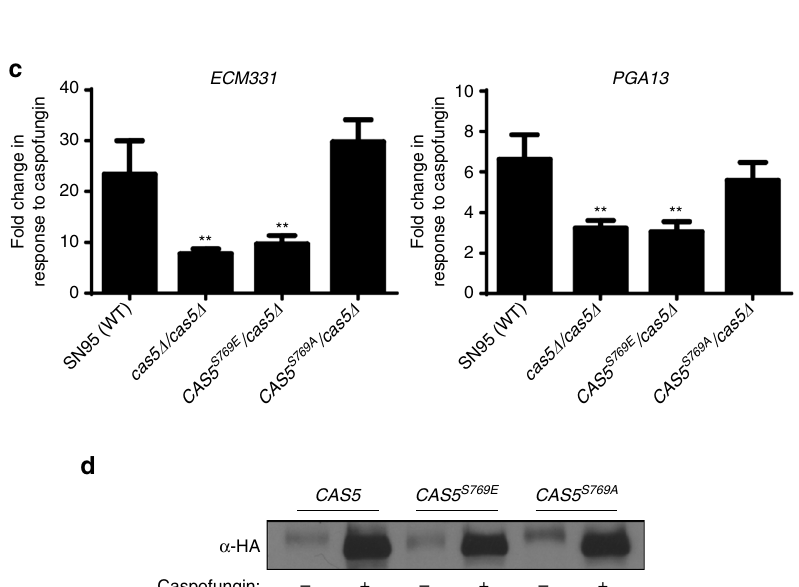
Fig. 6 The S769E substitution in the Cas5 DNA-binding domain phenocopies CAS5 deletion. a Schematic showing the position of S769 in the Cas5 zinc fi nger domain and the alignment of Cas5 orthologs in related fungal species. The alignment was performed using the Candida Genome Database (CGD), and the phosphorylation site-prediction score was generated using NetPhos. b The phosphomimetic S769E substitution in Cas5 confers hypersensitivity to caspofungin. Caspofungin susceptibility assays were conducted in YPD medium. Growth was measured by absorbance at 600 nm after 48 h at 30 °C. Optical densities were averaged for duplicate measurements. Data was quantitatively displayed with color using Treeview (see color bar in Fig. 2). c The S769E substitution blocks induction of cell wall genes in response to caspofungin treatment. The transcript levels of ECM331 and PGA13 were monitored by qRT-PCR and normalized to GPD1 . Plotted are the fold-changes in transcript levels of ECM331 or PGA13 in response to caspofungin relative to untreated. Error bars represent standard deviation (s.d.) from the mean of triplicate samples. The fold change in gene expression for each mutant strain was compared with the wild-type strain using one-way ANOVA in GraphPad Prism (** P < 0.01). d Phosphomutations in CAS5 do not affect band shifts associated with activation of the cell wall stress response, as observed upon caspofungin treatment. Cas5 was monitored by western blot and detected using an α -HA antibody. Full blots are shown in Supplementary Fig. Next, we assessed the ploidy of the cas5 Δ /cas5 Δ mutant cas5 Δ /cas5 Δ mutant exhibited fi ve distinct peaks at 2C, 4C, 6C, compared with a wild-type control by fl ow cytometry. During log 8C, and 12C (Fig. 9e and Supplementary Fig. 7c). Notably, peaks phase growth in the absence of external stress, wild-type cells at 1C and 3C were absent, indicating that the nuclei were not exhibited two distinct peaks at 2C and 4C (representing the haploidizing, mating, or undergoing reductional division. Instead, G1- and G2-phases of the cell cycle, respectively), whereas the these data suggest multiple rounds of DNA replication were